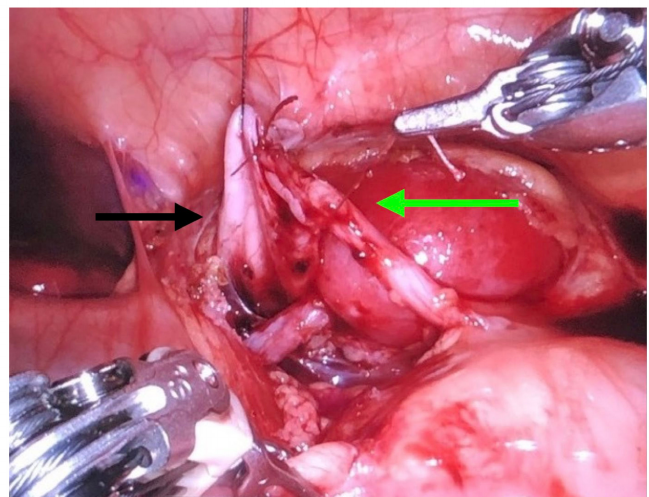
Figure 5. Robotic pyeloureteroplasty: renal pelvis ( black arrow ) and ureter ( green arrow ).